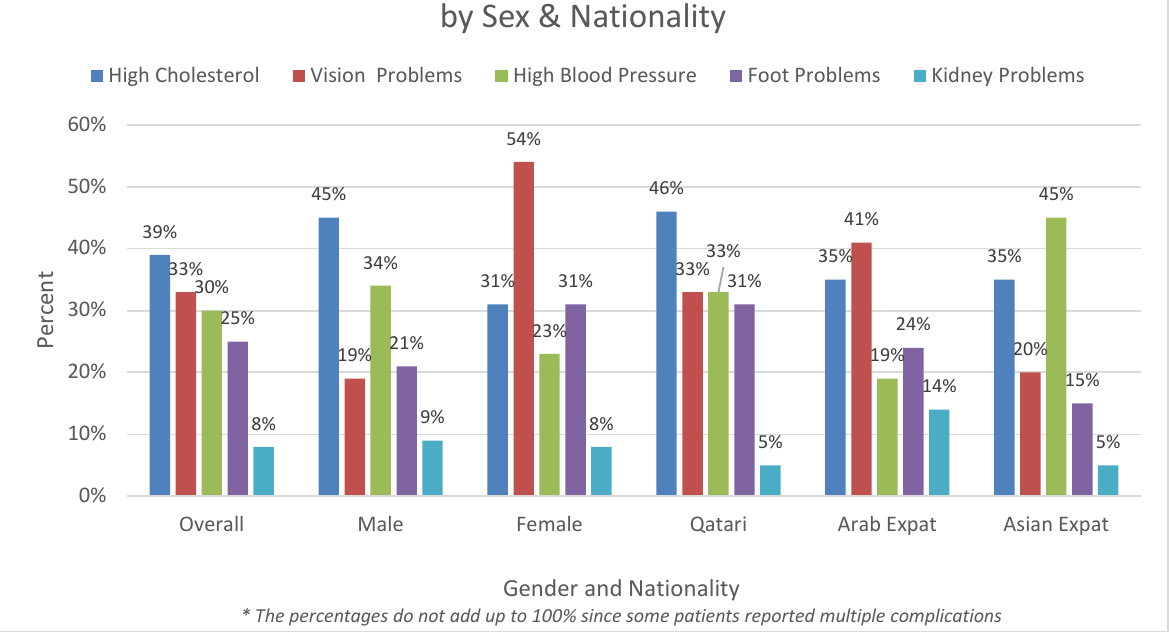
Figure 1 . Percentage of treated complications among diabetic